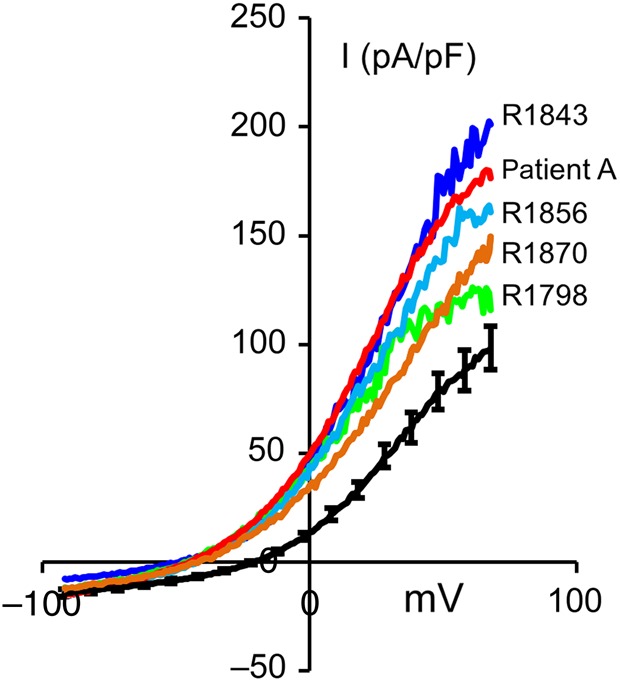
I–V traces from five IVF patients with strongly hyperpolarized Vm (<−40 mV). Black trace shows mean ± SEM I–V for donor cells (controls) prepared under identical conditions (See the Materials and Methods section).